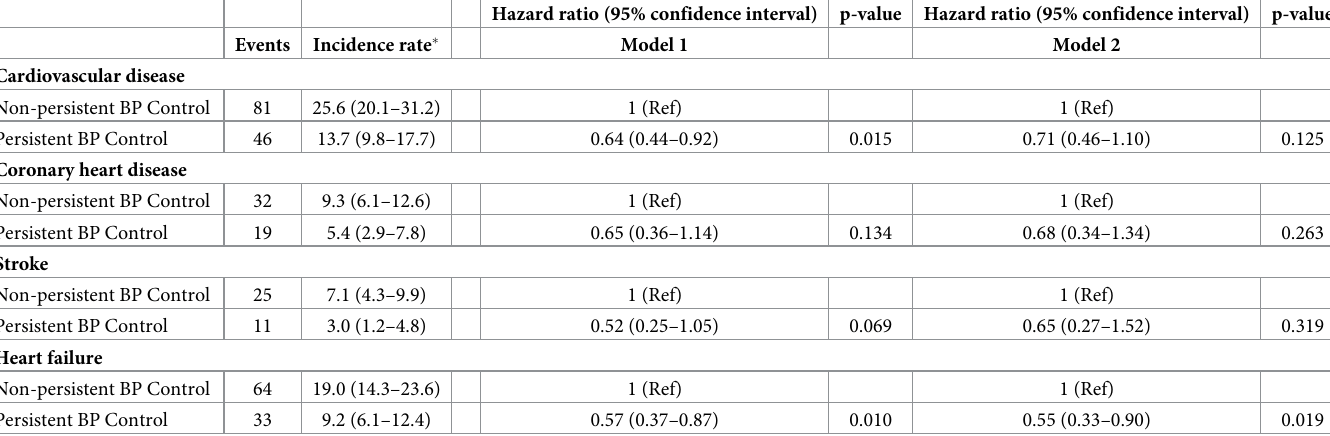
Table 4. Incidence rates and adjusted hazard ratios for cardiovascular events among participants with versus without persistent blood pressure control.